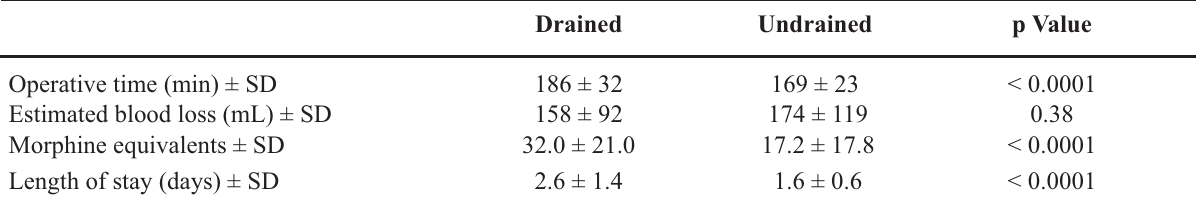
Table 2 – Operative and postoperative